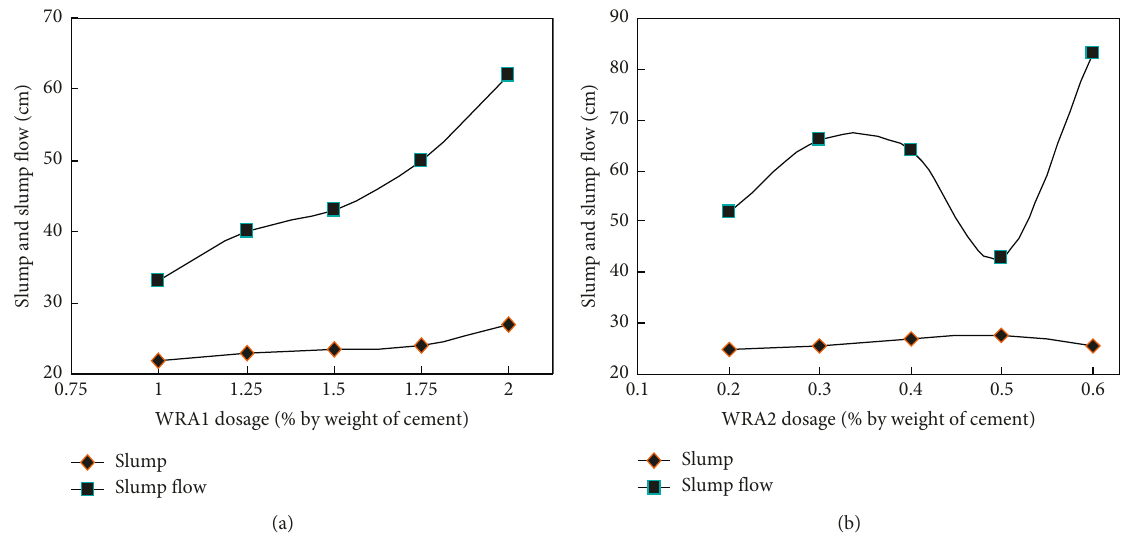
Figure 4: Slump and slump flow of CGCBM mixed with different dosage of